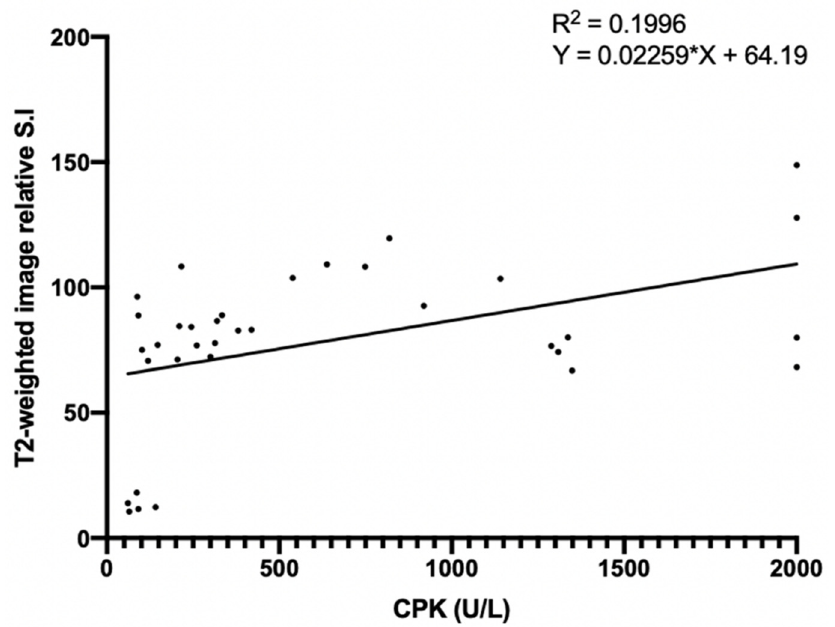
Figure 9. The correlation between the relative signal intensity of T2-weighted images and the CPK concentration. * (0.01 < p <